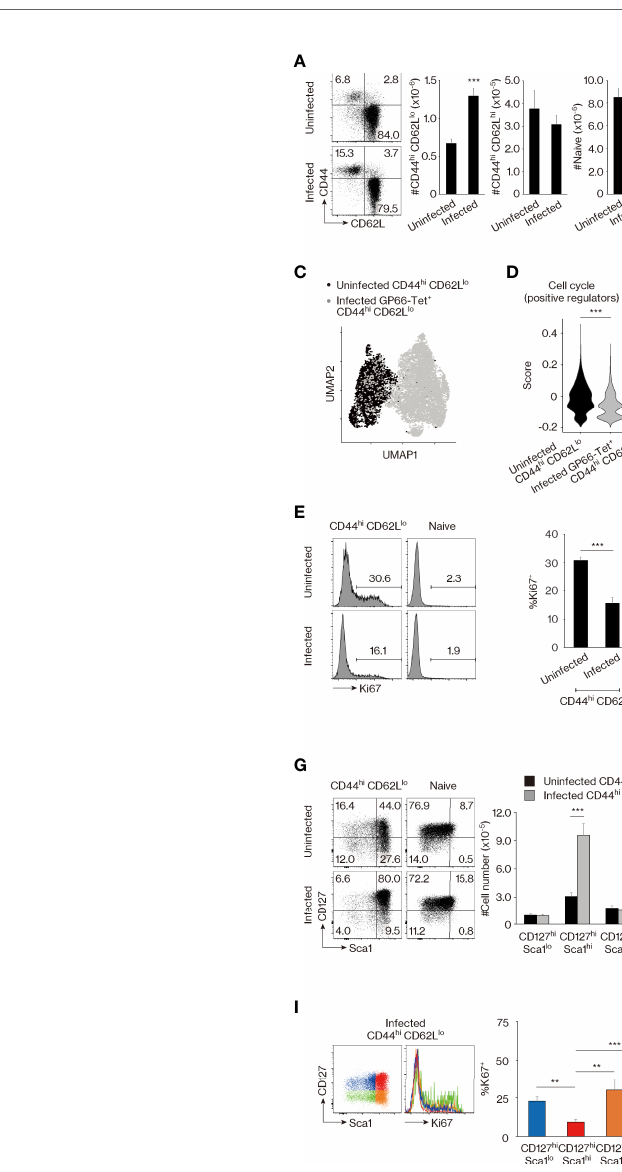
FIGURE 1 | CD44 hi CD62L lo CD4 + T lymphocytes represent a mixture of memory-phenotype (MP) and foreign antigen (Ag)-speci fi c memory cells. (A, B) CD44 hi CD62L lo CD4 + T-cell population size is larger in lymphocytic choriomeningitis virus (LCMV)-infected versus uninfected mice because of the presence of foreign Ag- speci fi c memory cells. (A) The representative dot plots show CD44 and CD62L expression in Foxp3 neg CD4 + T lymphocytes from uninfected and infected animals, while the bar graphs indicate the number (mean ± SD) of CD44 hi CD62L lo , CD44 hi CD62L hi , and CD44 lo CD62L hi (naïve) cells in the same T-cell population (n = 5 mice). (B) Dot plots displaying GP66-tetramer binding in CD44 hi CD62L lo CD4 + T lymphocytes from each group as well as a bar graph indicating the number (mean ± SD) of GP66-tetramer + cells in the indicated cell populations are shown (n = 5 mice). Data are representative of 3 independent experiments performed. (C,